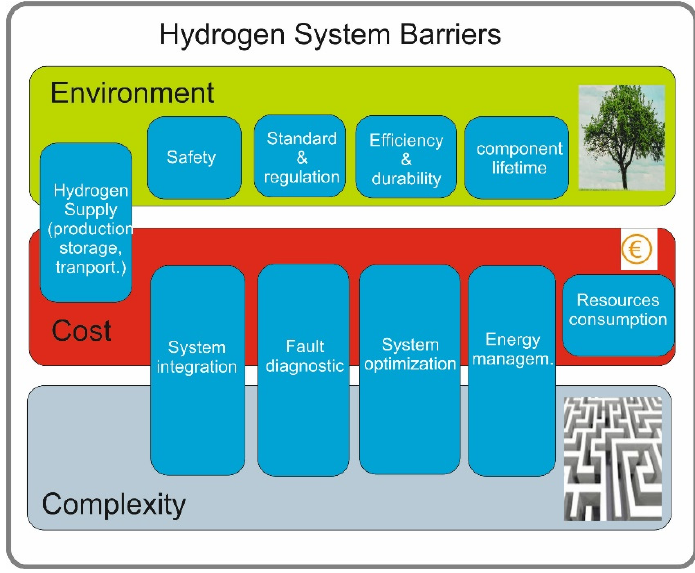
Figure 15. Hydrogen systems barriers representation (inspired by